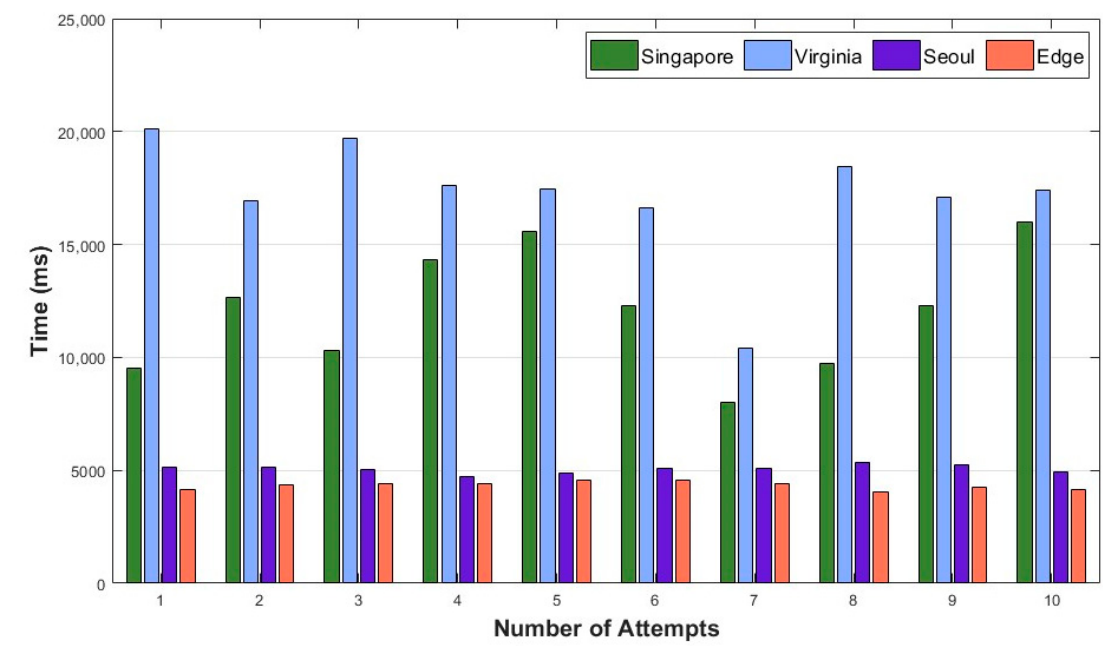
Figure 8. AR content load on the cloud server. Table 3. Average and standard deviation of the AR content load on cloud servers.